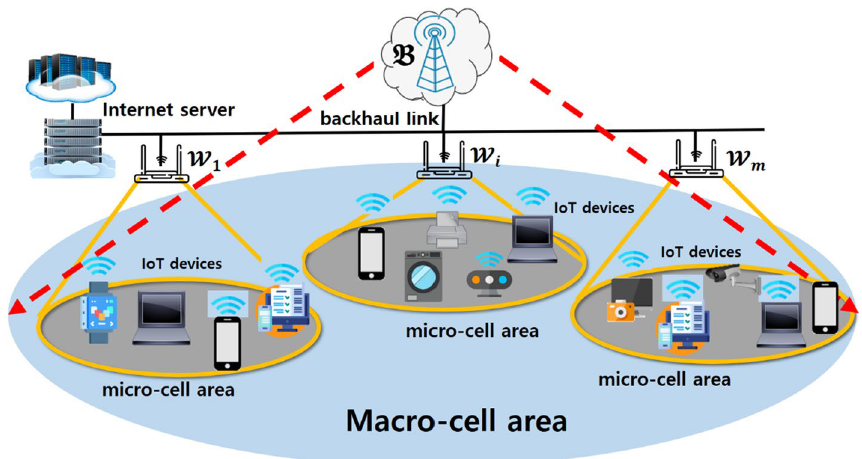
Fig. 1 LTE/WiFi platform architecture. In this study, the LTE/WiFi platform architecture stem consist of multiple smart devices, which is denoted as the set of IoT devices